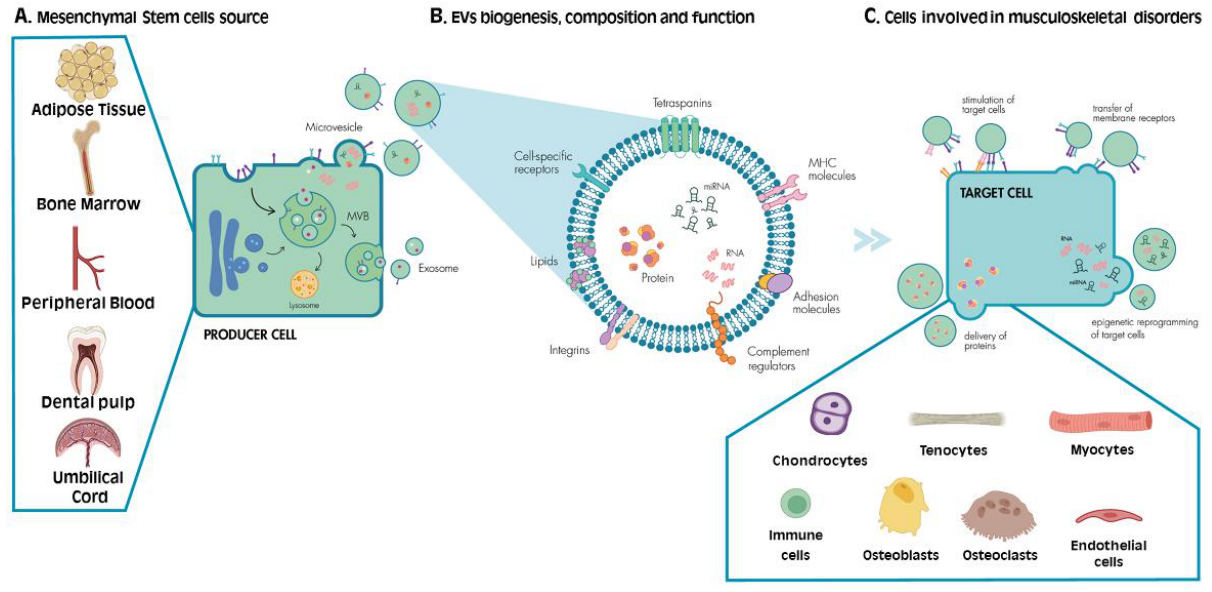
Figure 1. Cell-to-cell Communication via EVs in the Musculoskeletal System. ( A ) MSCs can be found in the bone marrow, adipose tissue, dental pulp, peripheral blood, umbilical cord, and among other tissues. ( B ) MSCs release EVs containing proteins, lipids, and nucleic acids (DNA and miRNA) to the surrounding environment. EVs can be formed either through plasma membrane budding (mi- crovesicles) or through an endosomal route (exosomes). ( C ) They express surface markers that in- teract with the membrane receptors of the target cells (chondrocytes, myocytes, osteoclasts, osteo- blasts, immune cells, tenocytes, among others) impacting the vesicle uptake and cargo delivery or directly stimulating and/or reprogramming the target cell. Created with BioRender.com.